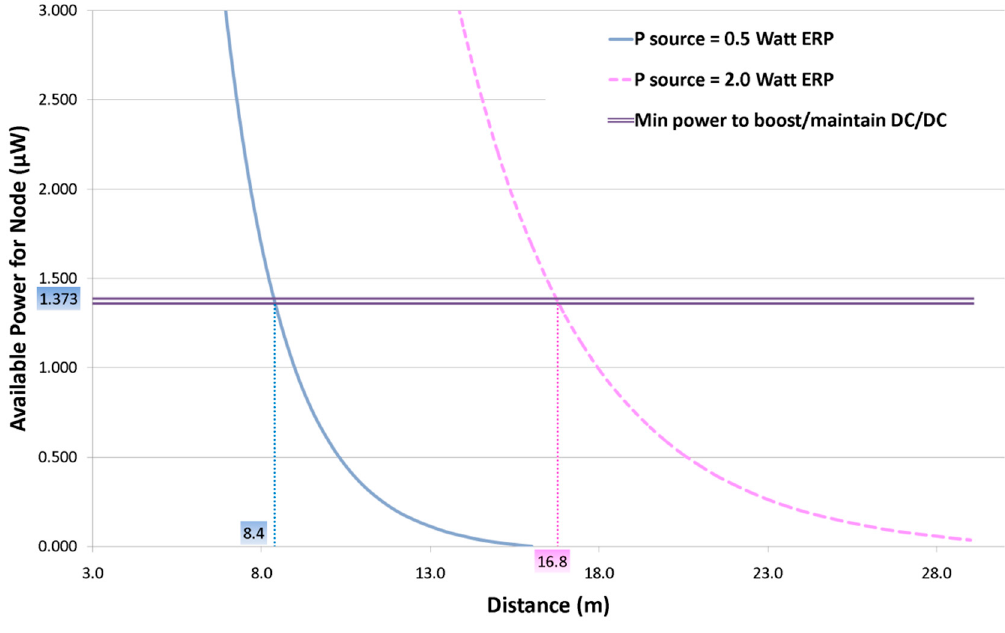
Figure 15. Power extracted vs. Node distance.